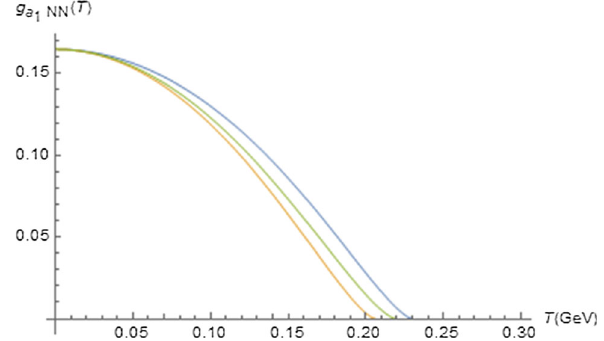
Fig. 1 g 0 ( T ) term at N f = 2, F = 87 MeV (orange line); N f = 3, F = 100 MeV (green line); N f = 5, F = 140 MeV (blue line)